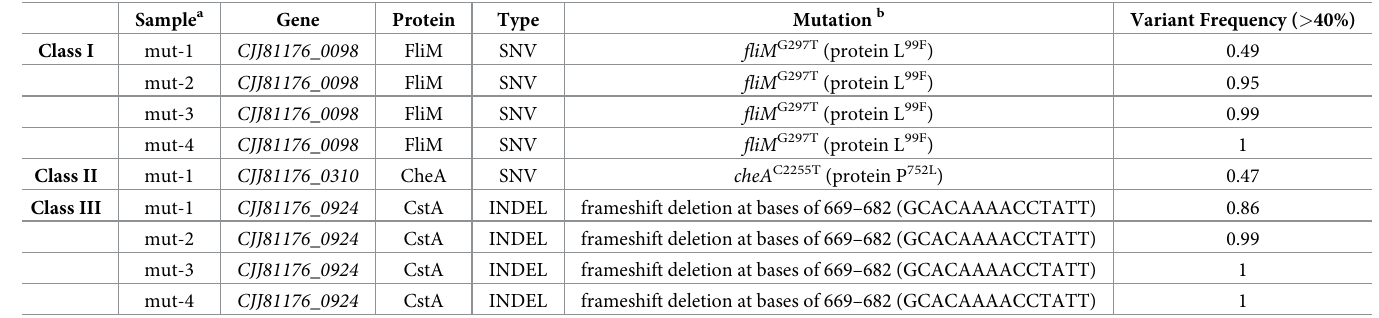
Table 1. Identification of Δ cheO suppressor mutations in C . jejuni 81–176.